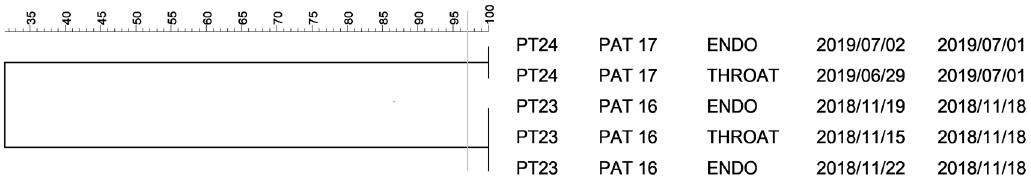
Figure 3. Dendrogram for restriction patterns of K. oxytoca isolates. Legend: horizontal axis—similarity of isolates (%); vertical axis—pulsotype, patient code, type of sample, date of sample collection, date of VAP diagnosis; PT pulsotype, PAT patient, ENDO endotracheal aspirate sample, THROAT throat swab. The vertical line indicates the similarity threshold set at 97%.